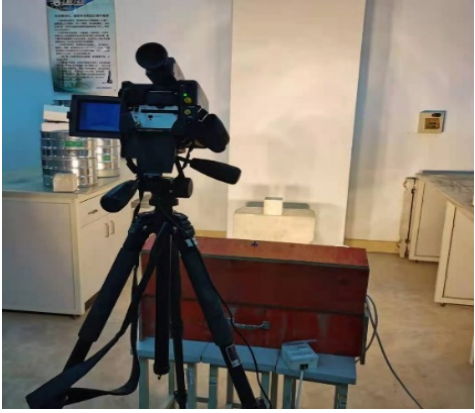
Figure 6. Infrared thermal image